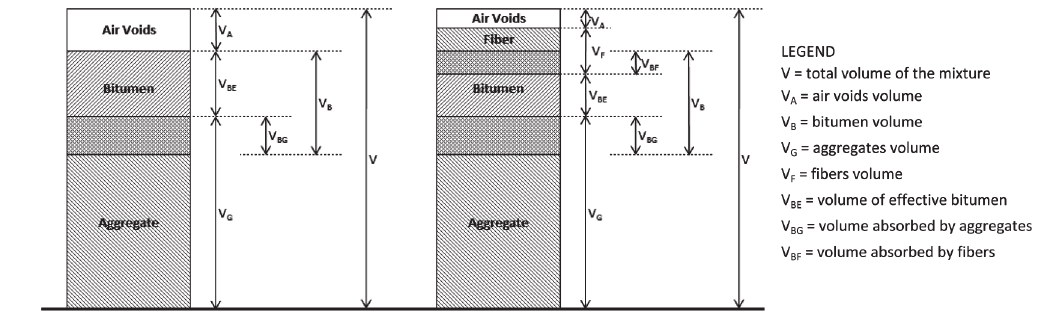
Fig. 5. Volume phase diagrams of standard and fiber-reinforced bituminous mixtures